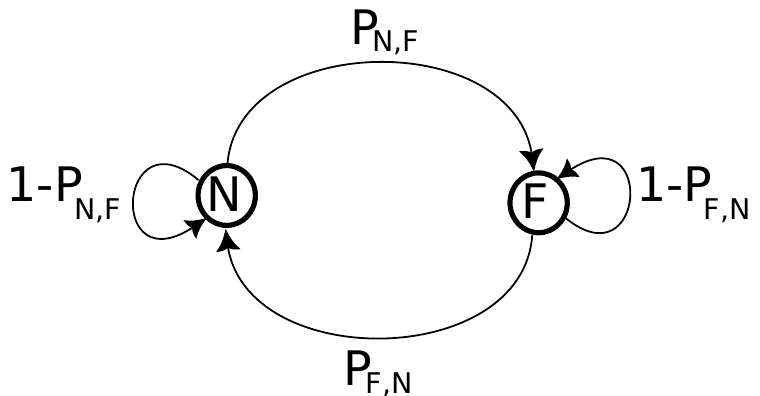
Figure 4. A two-state Markov chain to inject